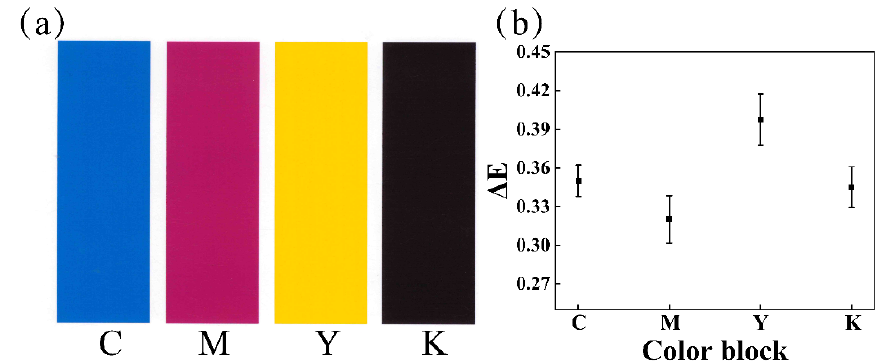
Figure 6. Inkjet printing color block and Δ E. ( a ) The prepared inkjet printing color block, ( b ) Δ E of inkjet printing color block. The inserted C, M, Y, and K represent cyan, magenta, yellow, and black, respectively.